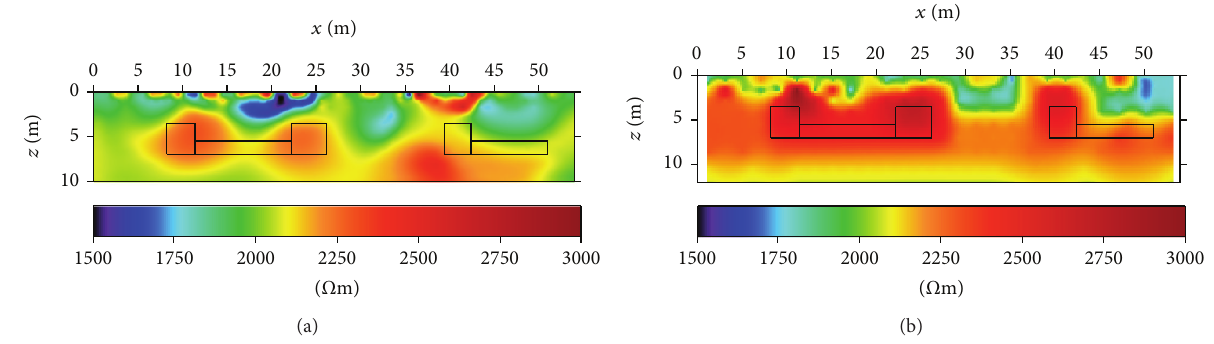
Figure 10: Results of the geoelectrical survey carried out on the test site of Marsala (Italy): (a) filtered Jacobian damped LSQR imaging; (b) standard least-squares constrain inversion. The superimposed black lines represent the real shapes of the